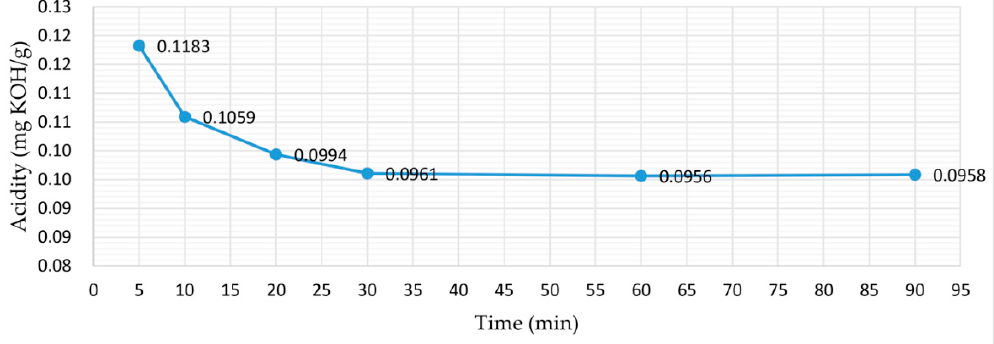
Figure 3. Effect of different alkali refining times on the acid value of CJCO. CJCO, crude Jatropha curcas Figure 3. E ff ect of di ff erent alkali refining times on the acid value of CJCO. CJCO, crude Jatropha oil. curcas